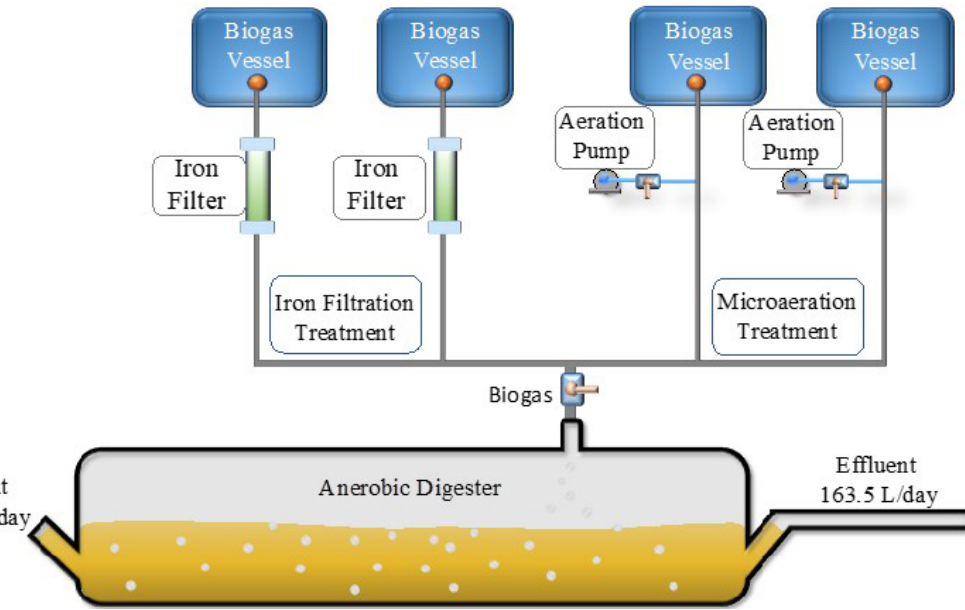
Figure 1. Schematic design of duplicate treatments for the desulfurization of biogas using iron filtration and microaeration.